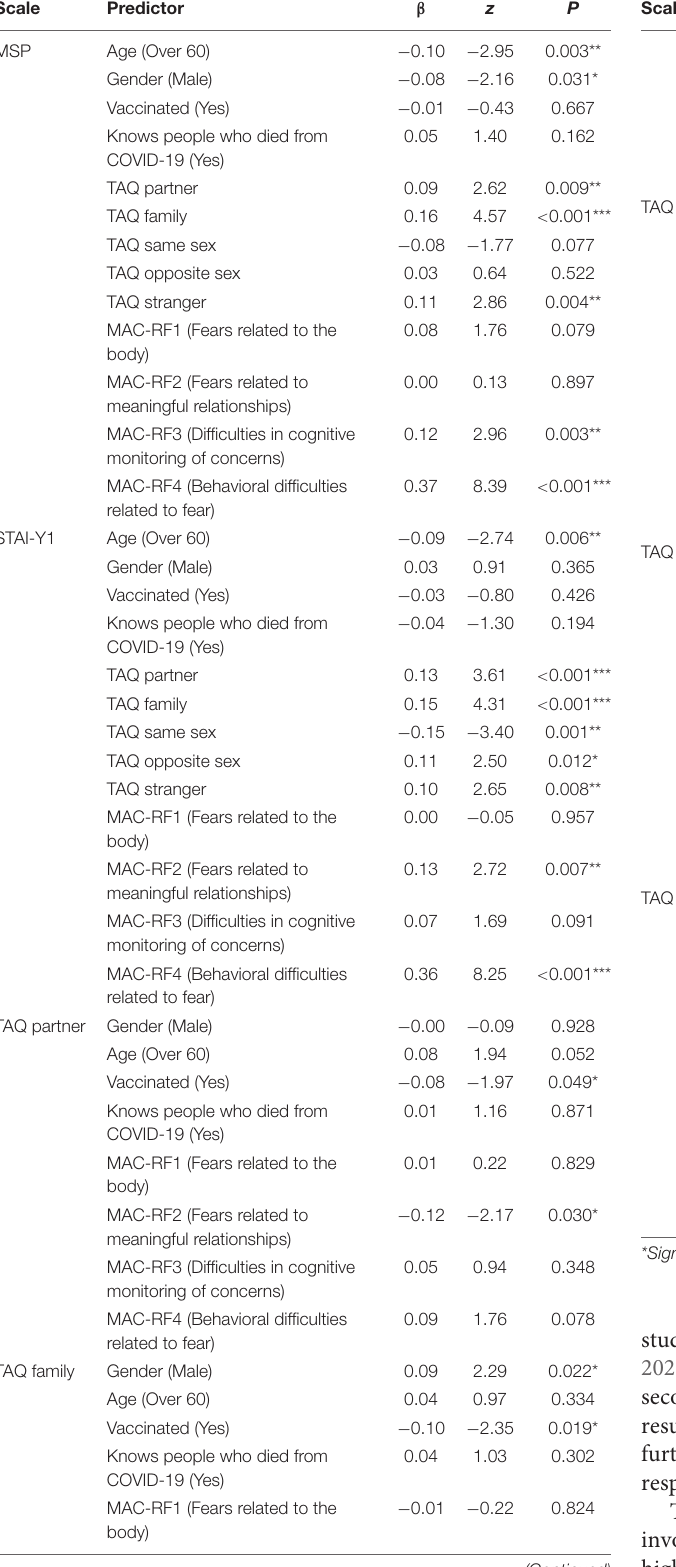
TABLE 4 | Path analysis predicting MSP and STAI-Y1